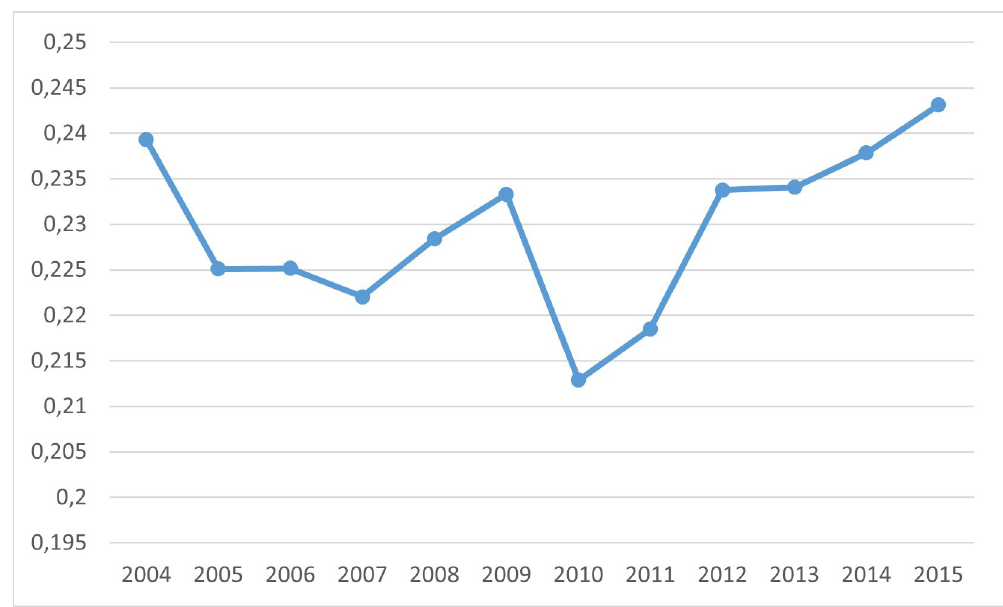
Fig 4. Percentage of intellectual capital stock on total assets by